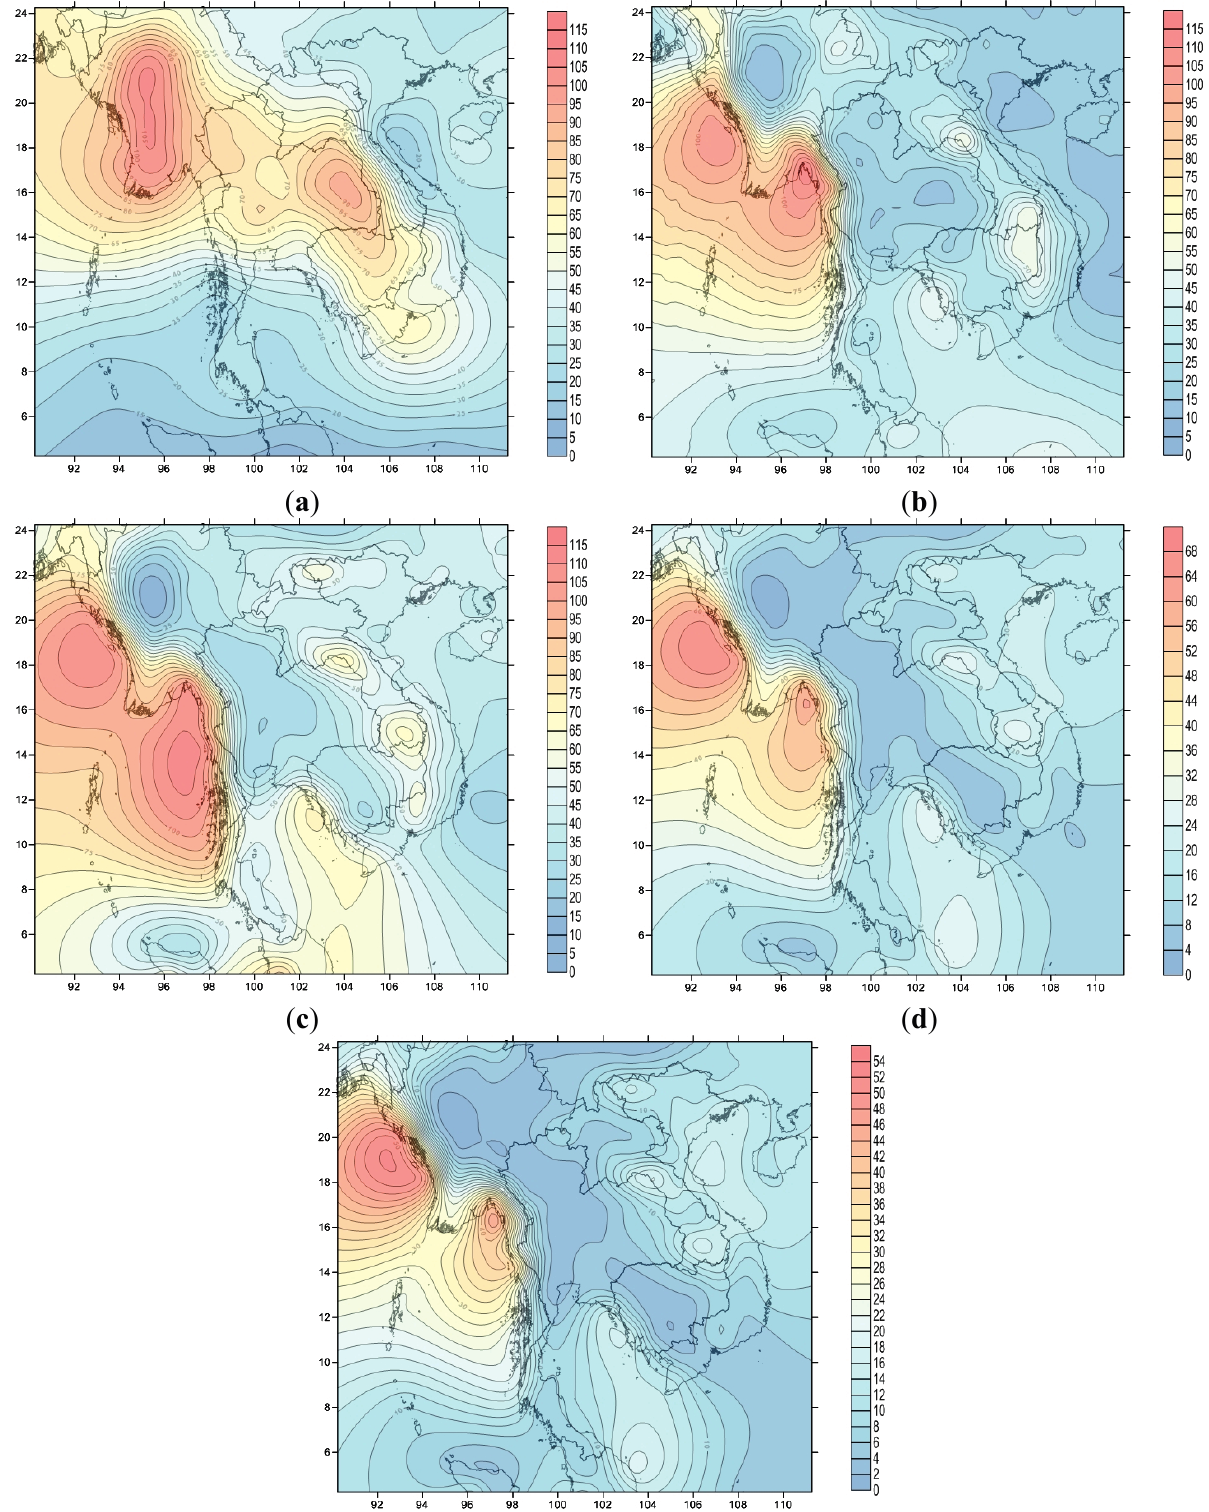
Figure 3. Spatial analysis of frequency indices of mean climatology over the Indochina Peninsula (Days). ( a ) CDD; ( b ) CWD; ( c ) R10mm; ( d ) R20mm; ( e )